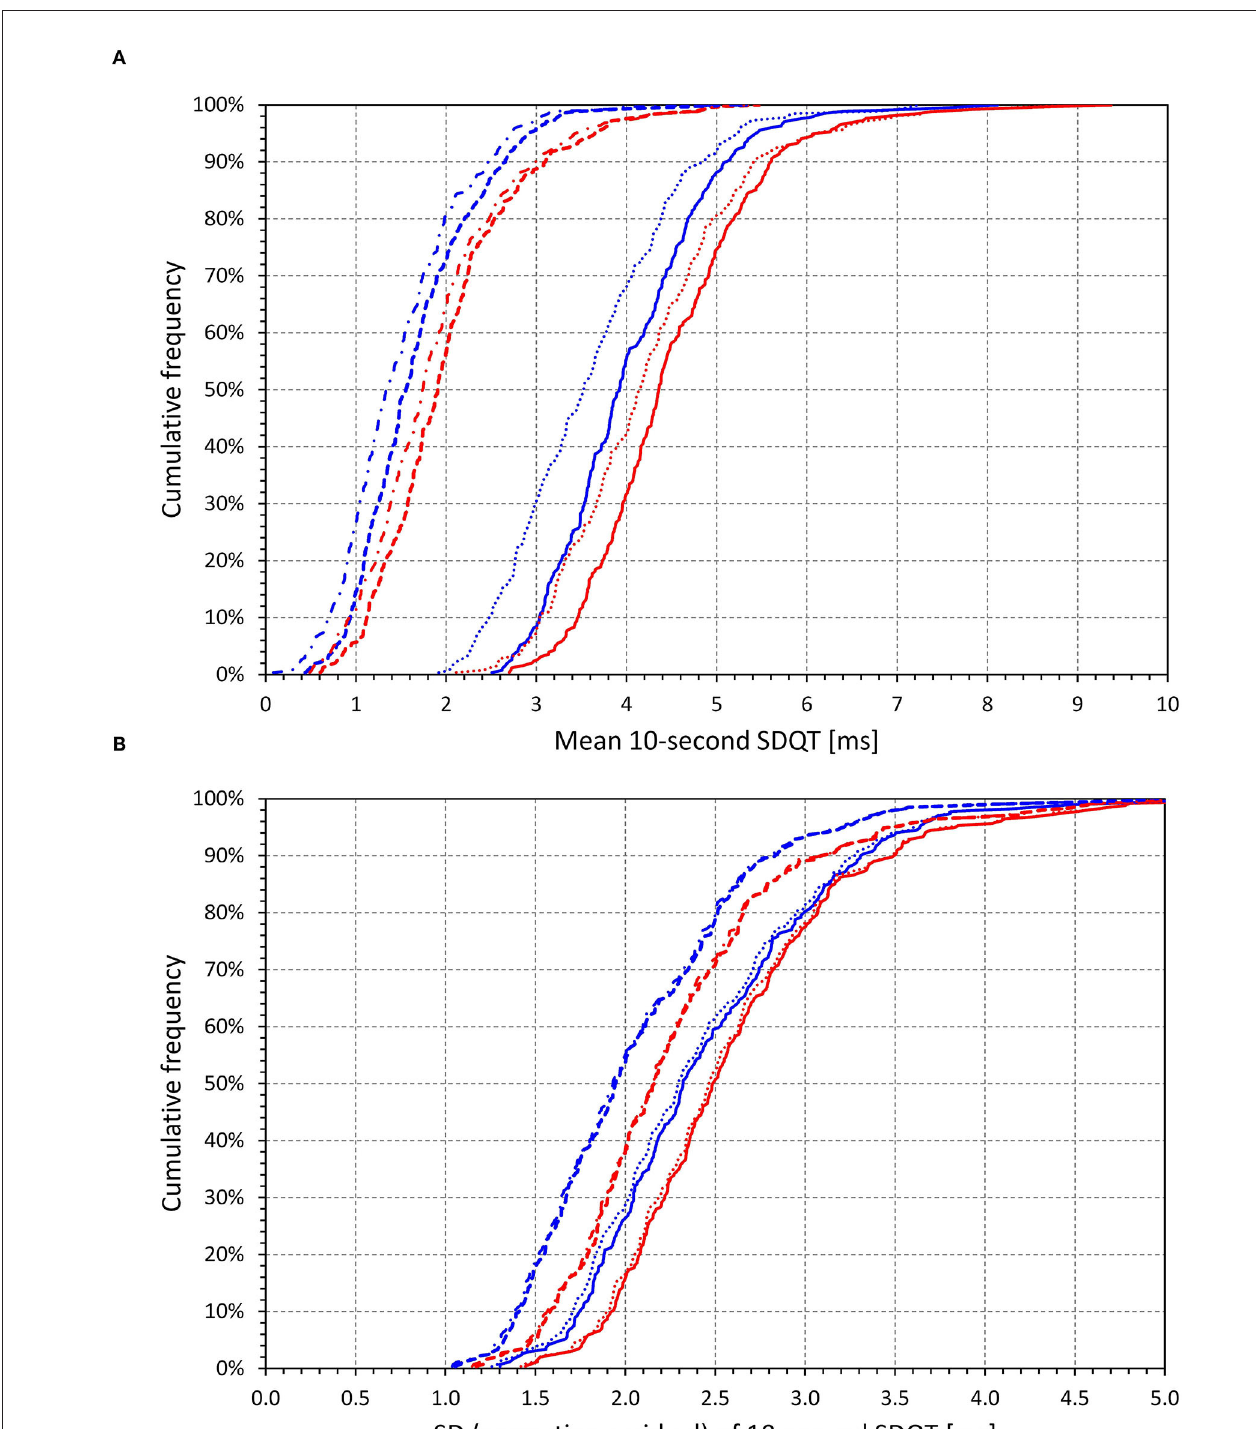
FIGURE 11 | Cumulative distributions of intra-subject means of 10-s SDQT [top (A) ] and of intra-subject standard deviations of the 10-s SDQT [bottom (B) ]. The full lines show the distribution of source data without any regression correction, the dotted lines regression-corrected SDQT values for SDRR [top (A) ] and residuals of linear regression of SDQT to SDRR [bottom (B) ], the bold dashed lines regression-corrected SDQT values for 10-s median beat noise [top (A) ] and residuals of linear regression of SDQT to 10-s median beat noise [bottom (B) ], and dashed and dotted lines regression-corrected SDQT values for a combination of SDRR and 10-s median beat noise [top (A) ] and residuals of linear regression of SDQT to a combination of SDRR and 10-s median beat noise [bottom (B) ]. The red and blue lines in both panes correspond to females and males, respectively.